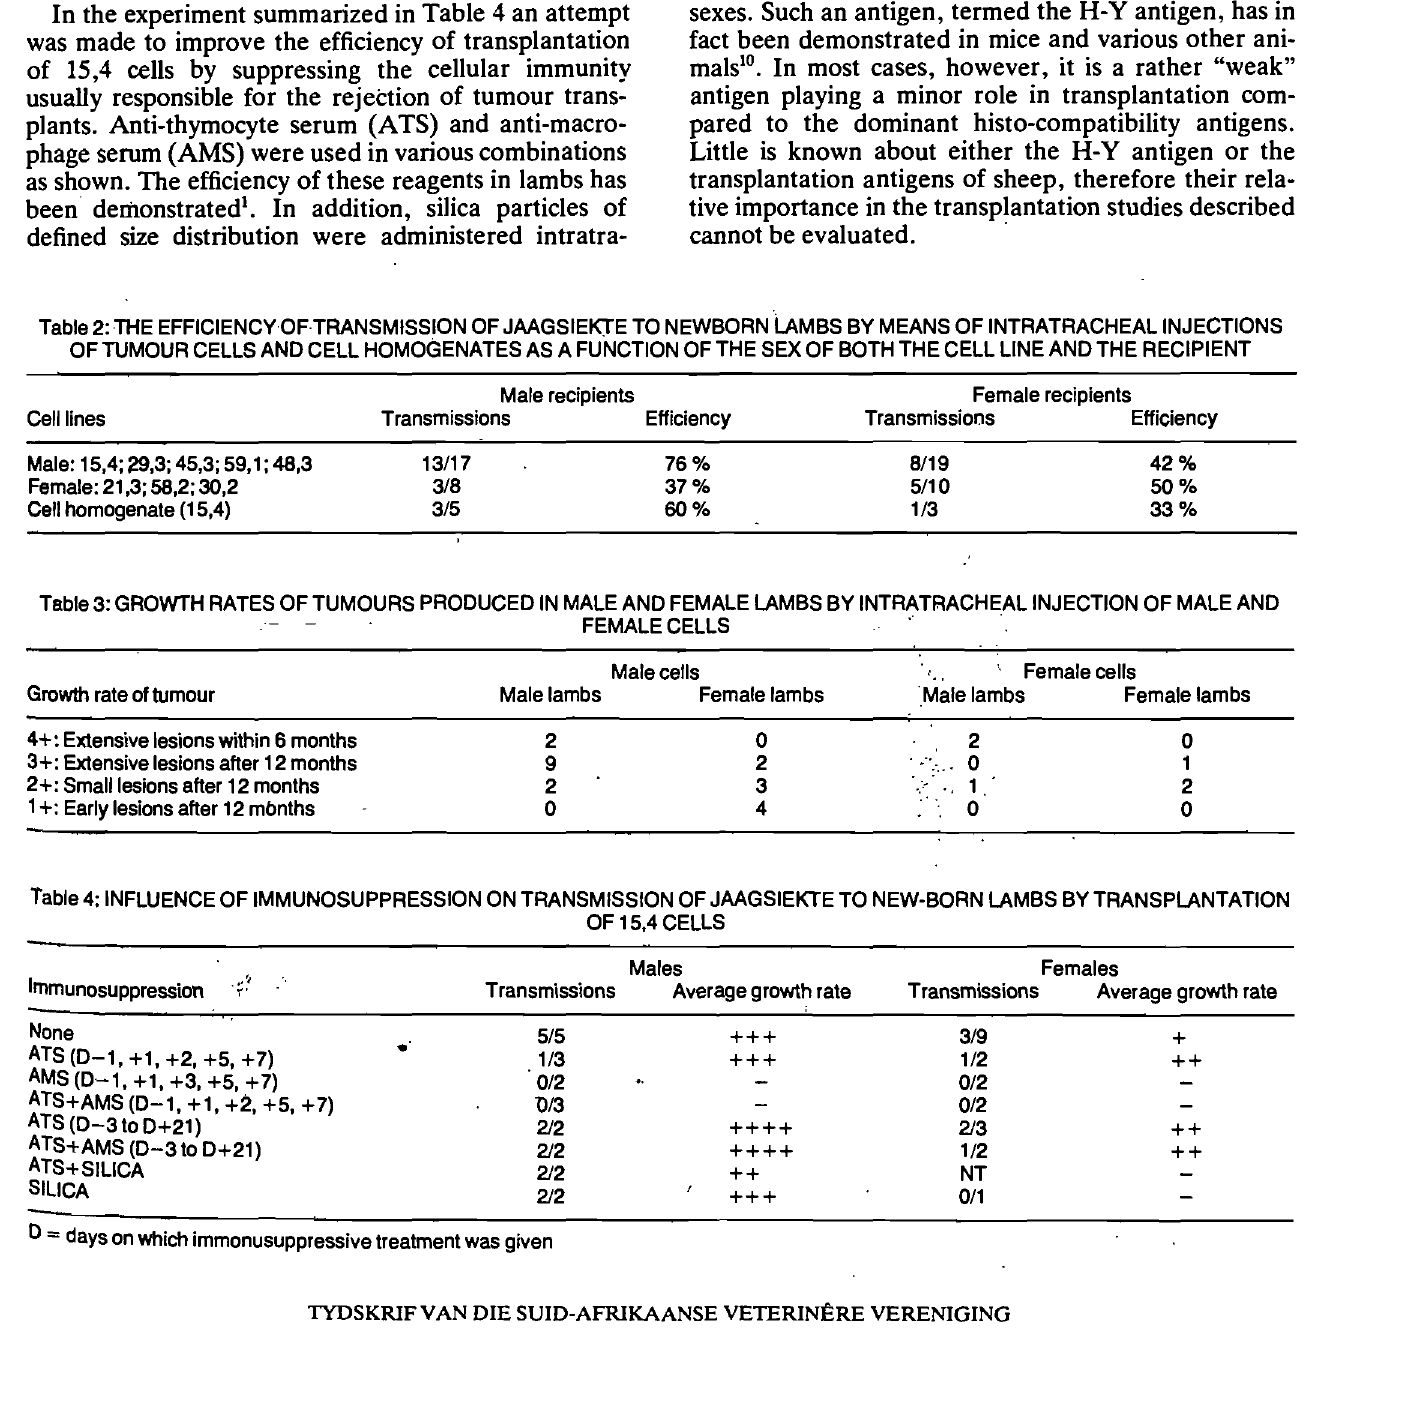
Table 2: THE EFFICIENCYOFTRANSMISSION OF JAAGSIEKTE TO NEWBORN LAMBS BY MEANS OF INTRATRACHEAL INJECTIONS OF TUMOUR CELLS AND CELL HOMOGENATES AS A FUNCTION OF THE SEX OF BOTH THE CELL LINE AND THE RECIPIENT